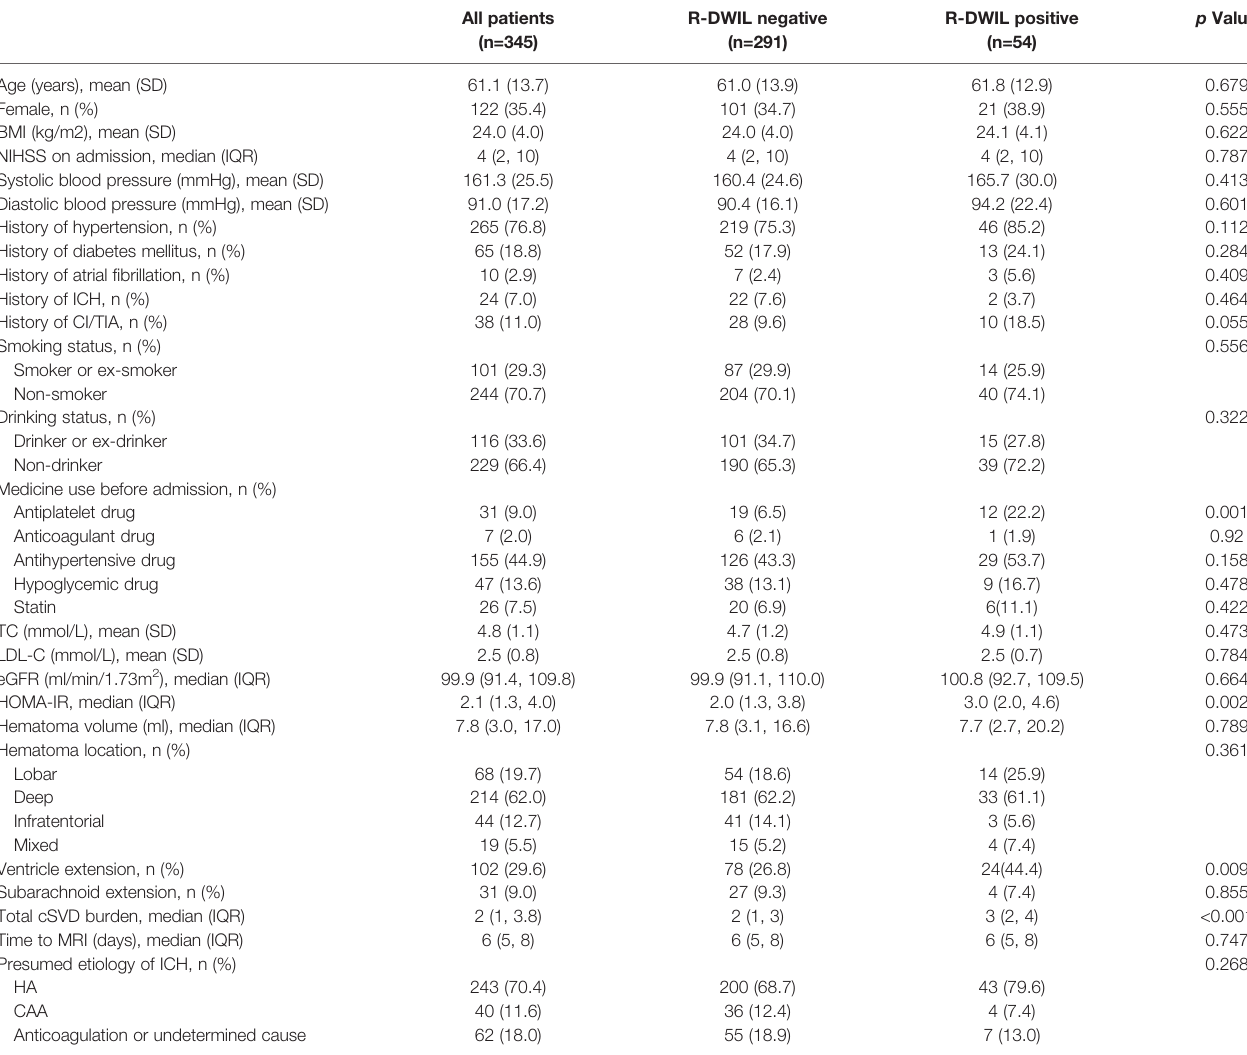
TABLE 1 | Baseline characteristics of patients with and without R-DWIL.